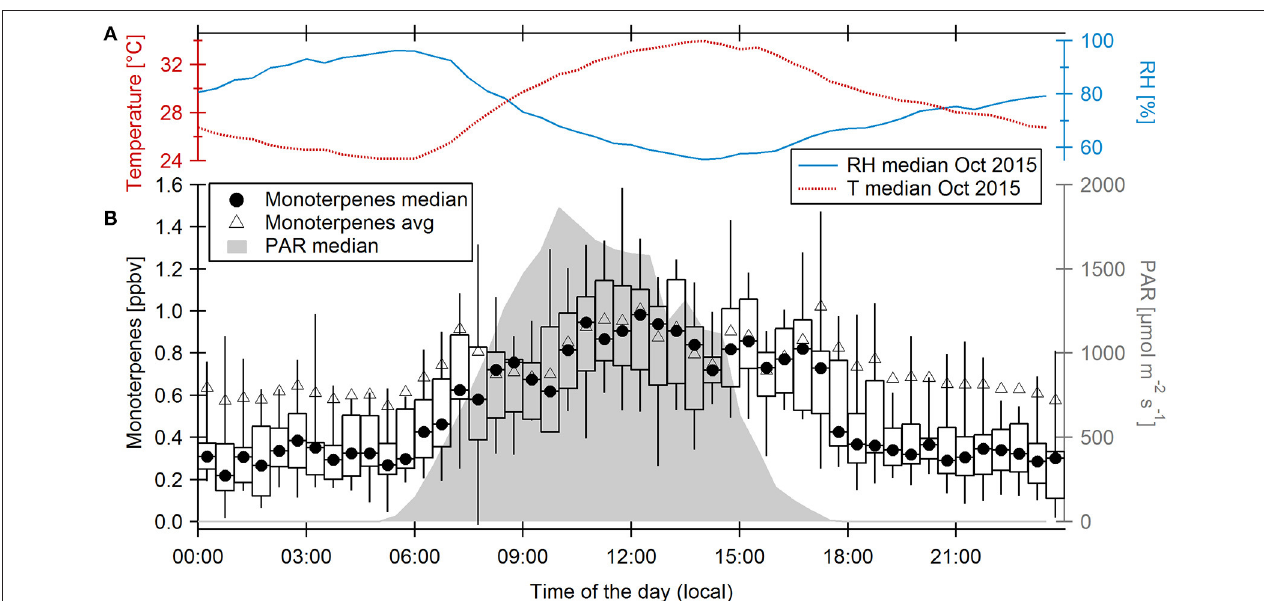
FIGURE 9 | (A) Diel cycles of temperature and relative humidity measured at 41m above ground level in October 2015. (B) Diel cycle of ambient monoterpene mixing ratios measured at 38m above ground level during 12 days in October 2015 showing half-hourly monoterpene medians (circles) and averages (triangles). Boxes and whiskers represent the 25–75th and 5–95th percentiles, respectively. The diel cycle of photosynthetic active radiation (PAR) is displayed on the right